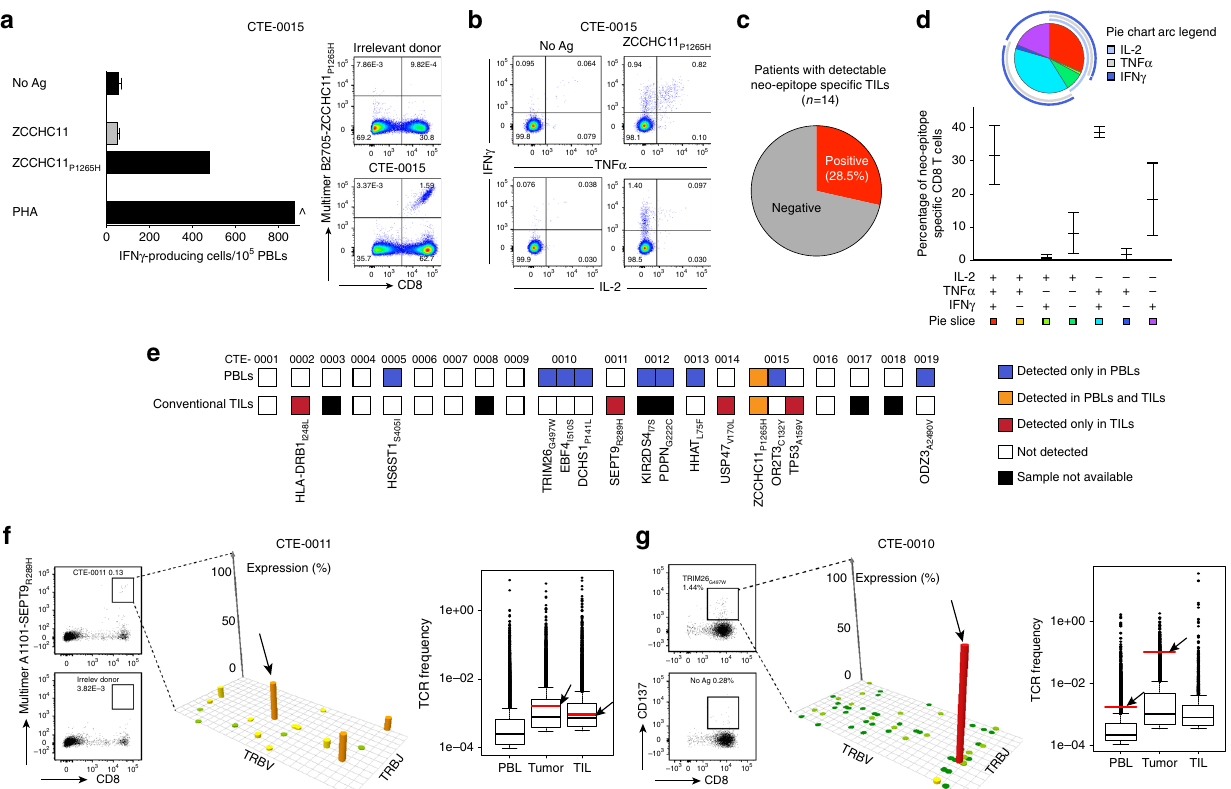
Fig. 2 Identi fi cation of neo-epitope speci fi c TILs. a – c Representative example of neo-epitope ( ZCCHC11 P1265H )-speci fi c TILs in patient CTE-0015. a IFN γ ELISpot showing the average of triplicate + SD (PHA: phytohemagglutinin; No Ag: no peptide) and peptide-MHC multimer staining. All other neo-epitopes are described in Supplementary Fig. 3 and Table 2. b Intracellular cytokine staining showing the frequency of viable IFN γ , TNF α , and IL-2 cytokine- producing TILs. c Proportion of patients with neo-epitope reactive TILs. d Cumulative analysis (SPICE) showing the functional composition (cytokine pro fi les) of neo-epitope speci fi c TILs (mean ± SD). e Repertoire of neo-epitopes in PBLs and TILs in 19 patients. Each colored square represents one neo- epitope for which T-cell reactivity was validated either exclusively in PBLs (blue), exclusively in TILs (red), in both compartments (orange) or in none of them (white). For 5 out of 19 patients no tumor samples were available for TIL generation (black squares). f Neo-epitope-speci fi c TILs from patient CTE- 0011 were FACS sorted with HLA-A1101- SEPT9 R289H multimer. Sorted cells (left) underwent TCR sequencing, as well as autologous bulk PBLs, bulk tumor and bulk TIL cultures. The Manhattan plot reports the V/J recombination of the T-cell receptor β (TCR β ) of SEPT9 R289H -speci fi c T cells: V and J segments are represented according to chromosomal location on the x and y -axis, respectively. On the right, the distribution of the TCR frequencies is shown for PBL, tumor and TILs. Dominant SEPT9 R289H -speci fi c TCR β are identi fi ed by red bars (and arrows) in tumor and TILS, whereas no SEPT9 R289H -speci fi c TCRs was identi fi ed in PBLs. g TRIM26 G497W -speci fi c circulating T cells from patient CTE-0010 were isolated based on CD137 upregulation and immediately processed for TCR-sequencing analysis (center). TCR repertoire analysis was performed in parallel on matched bulk PBLs, bulk tumor, and bulk TIL cultures (right). The most frequent shared neo-epitope speci fi c TCR was ranked according to its relative frequency in PBL and tumor (red bars and arrows). The same TCR was undetectable in IL-2-expanded TIL cultures. Elements of box plots represent median (line), 25% and 75% con fi dence limit (box limits) and 10% and 90% con fi dence limit